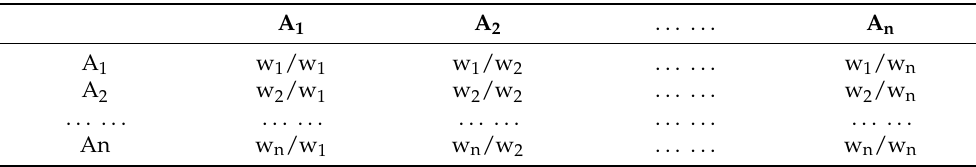
Table 6. Pairwise comparison